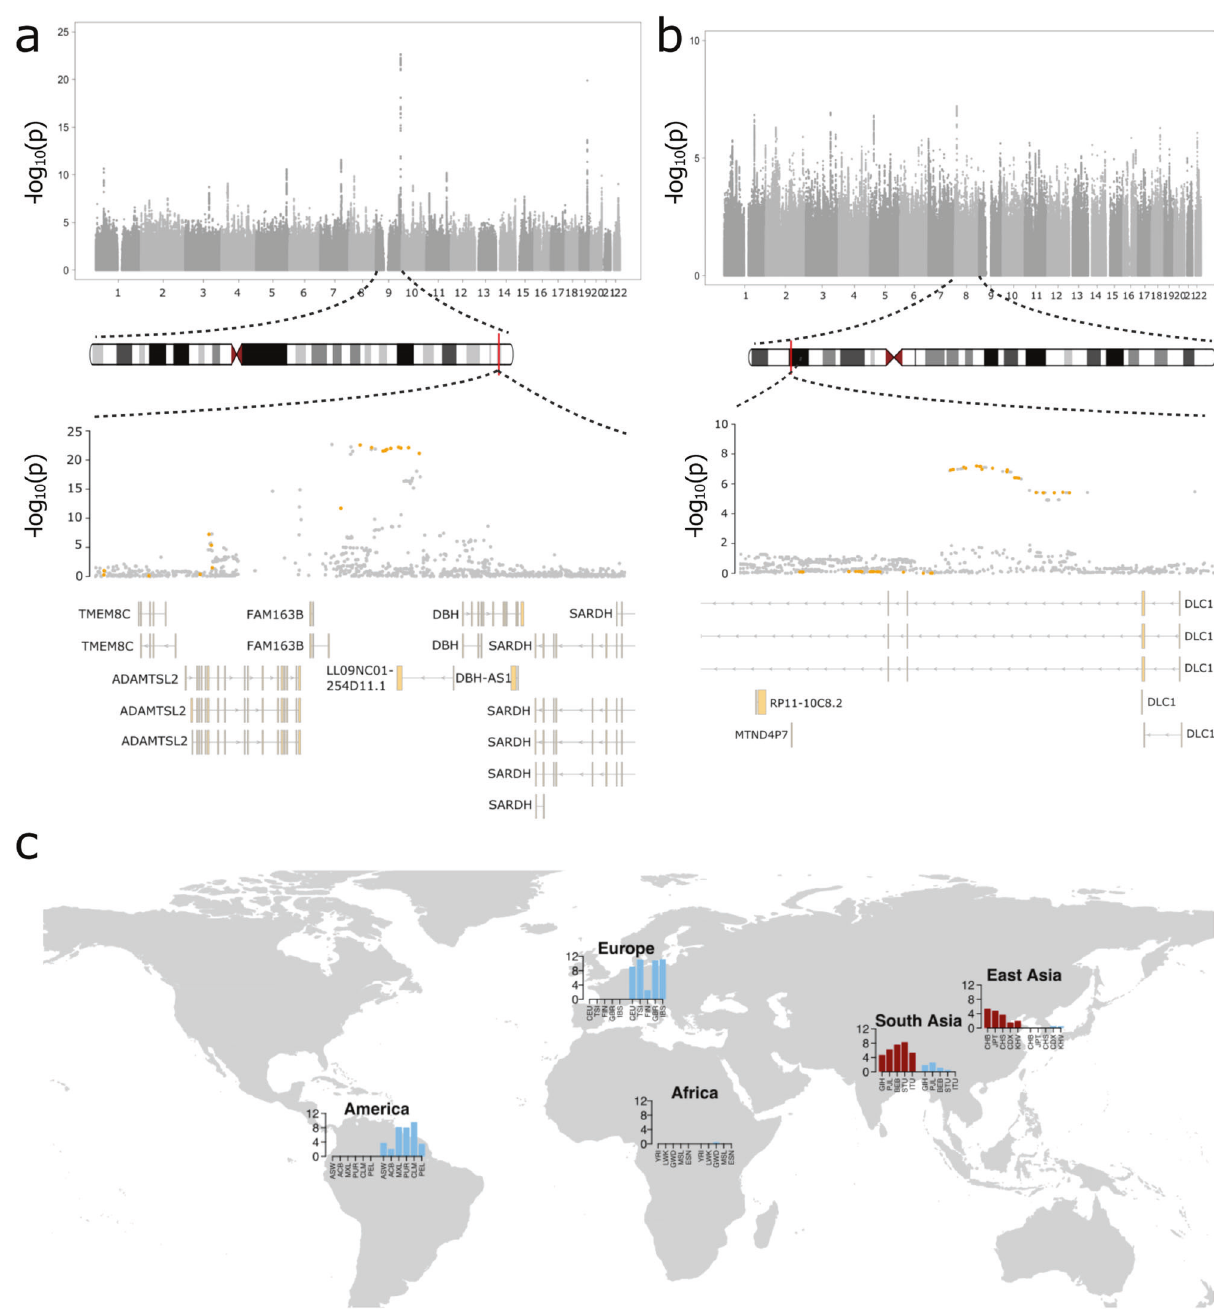
Fig. 2 Top smoking risk loci in UK Biobank and Biobank Japan are linked to Neandertal DNA. a , b Manhattan plots for the ‘ Current smoking status ’ GWAS in the UK Biobank ( a ) and ‘ Ever smoked ’ GWAS in the Biobank Japan ( b ) are shown in the respective upper parts of the panels. A magni fi ed view centered ( + − 100,000 base pairs) around the top genome-wide associations on chromosome 9 ( a , chr9:136,363,019 – 136,563,019, P = 2.7 × 10 − 23 ) and chromosome 8 ( b , chr8:12,889,111 – 13,689,111, P = 6.7 × 10 − 8 ) are displayed in the lower parts of a and b . Here, aSNPs are highlighted in orange. Overlapping genes and their gene models are shown in the lower part of the panel. c The frequency of the archaic alleles for the two top associated aSNPs (dark red: rs113382419 , chr9:136,463,019; and light blue: rs76591447 , chr8:13,289,111) in present-day 1000 Genomes continental populations are